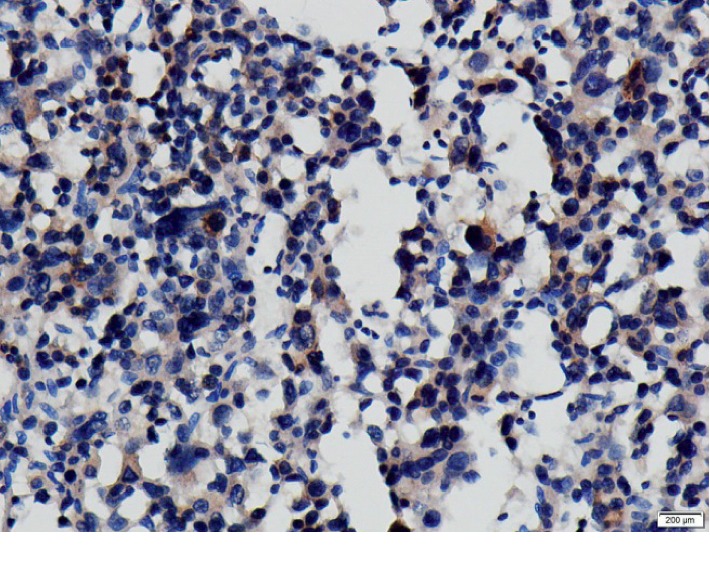
ACTH Immunostaining: few scattered tumor cells showing granular cytoplasmic positivity.